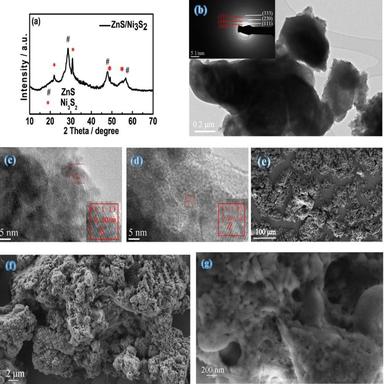
(a) XRD pattern, (b, c, d) TEM images, and (e, f, g) SEM images of ZnS/Ni3S2; the insets in (c), (d) are the HRTEM images.